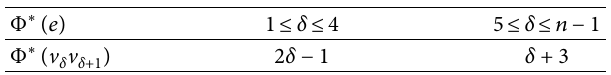
Table 4: Edge labeling of Φ ∗ ( e ) .